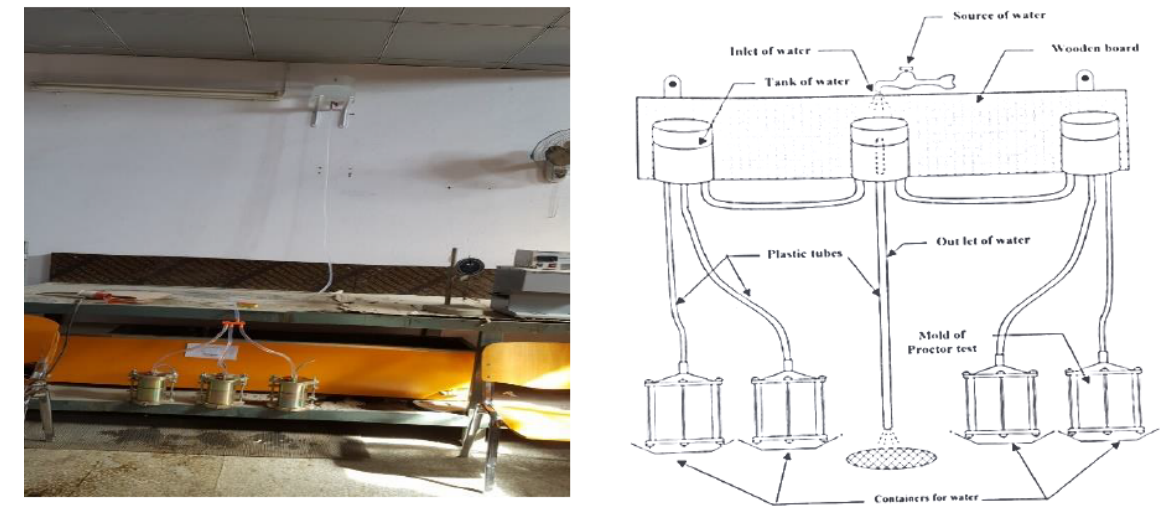
Figure 2: Model setup for the permeability and durability test